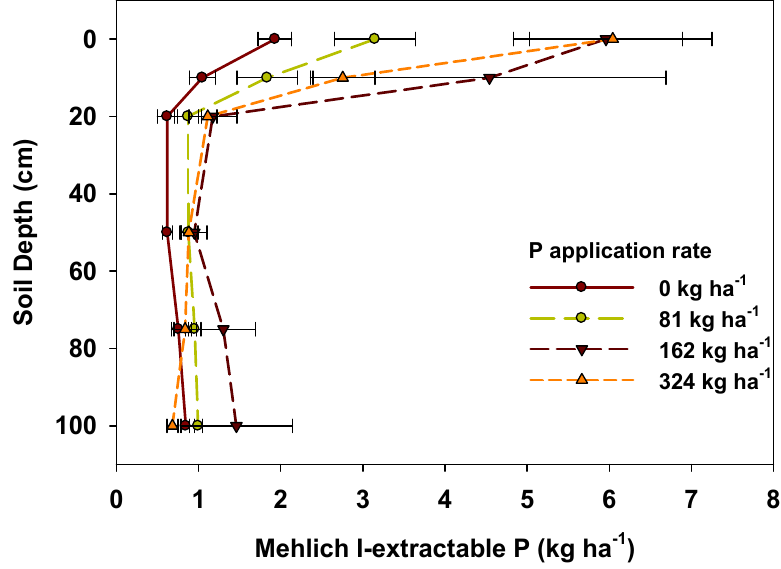
Figure 2. Mehlich I extractable phosphorus in a loamy Ultisol in the western Gulf Coastal Plain of the United States 27 years after high rates of triple superphosphate